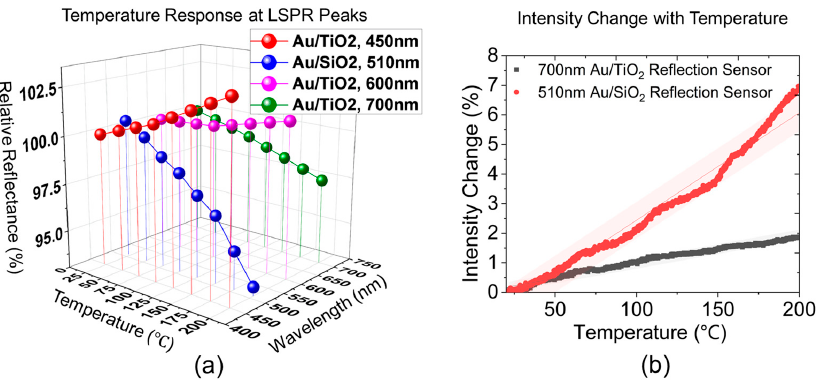
Figure 12. ( a ) Temperature responses demodulated at individual LSPR peaks of Au/TiO 2 sensor compared to the dominant LSPR peak (510 nm) of Au/SiO 2 sensor. ( b ) Percent change in relative reflectance of Au/TiO 2 at 700 nm compared to Au/SiO 2 at 510 nm as a function of temperature, with linear fit to the data within 95% prediction band.